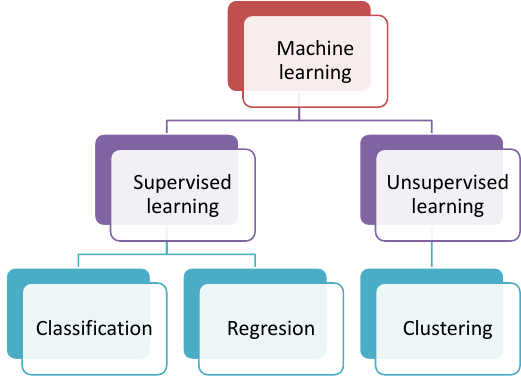
Figure 2. Classification of the machine learning approaches according to the